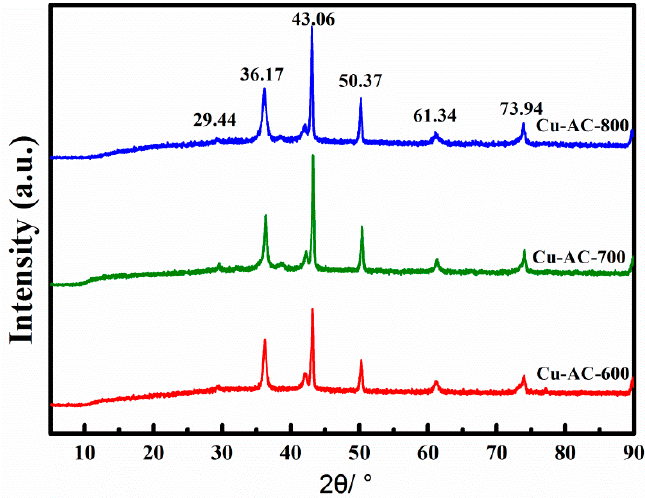
Figure 1. XRD patterns of the Cu-AC samples at different activation temperatures.